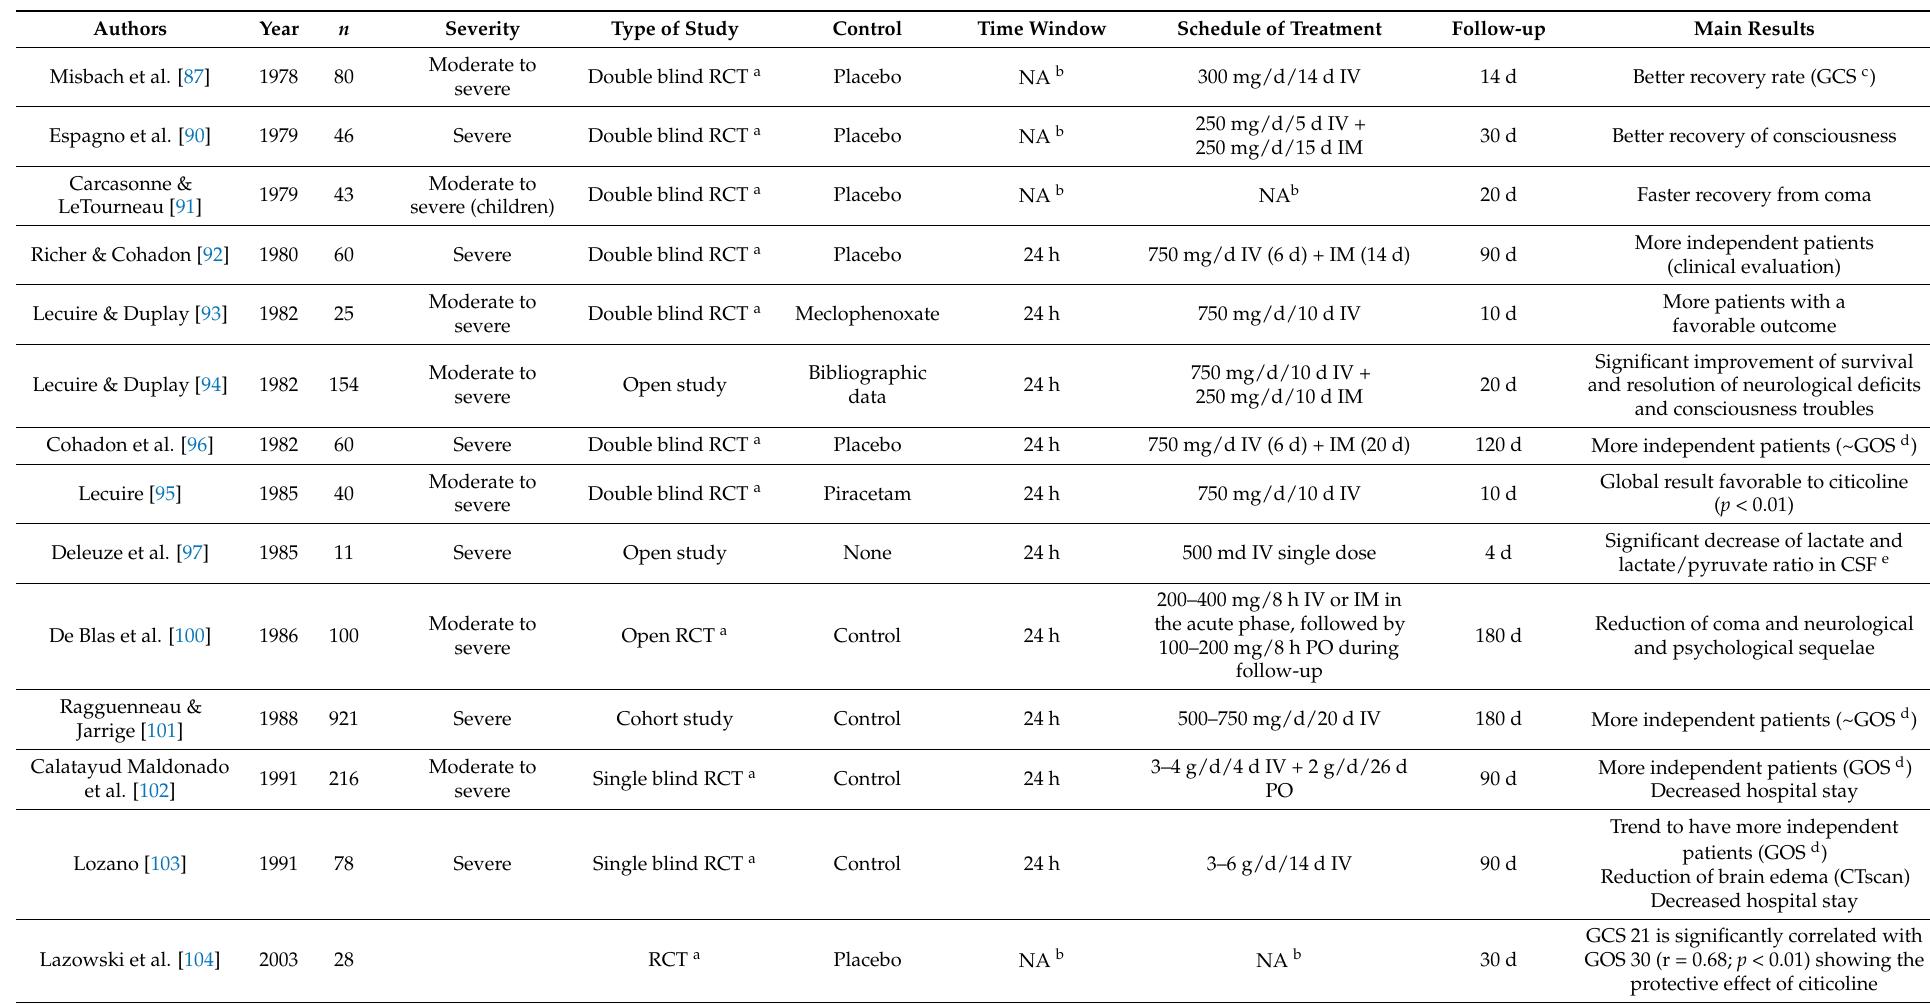
Table 3. Summary of clinical studies evaluating the effects of citicoline in the management of patients with mild to severe traumatic brain